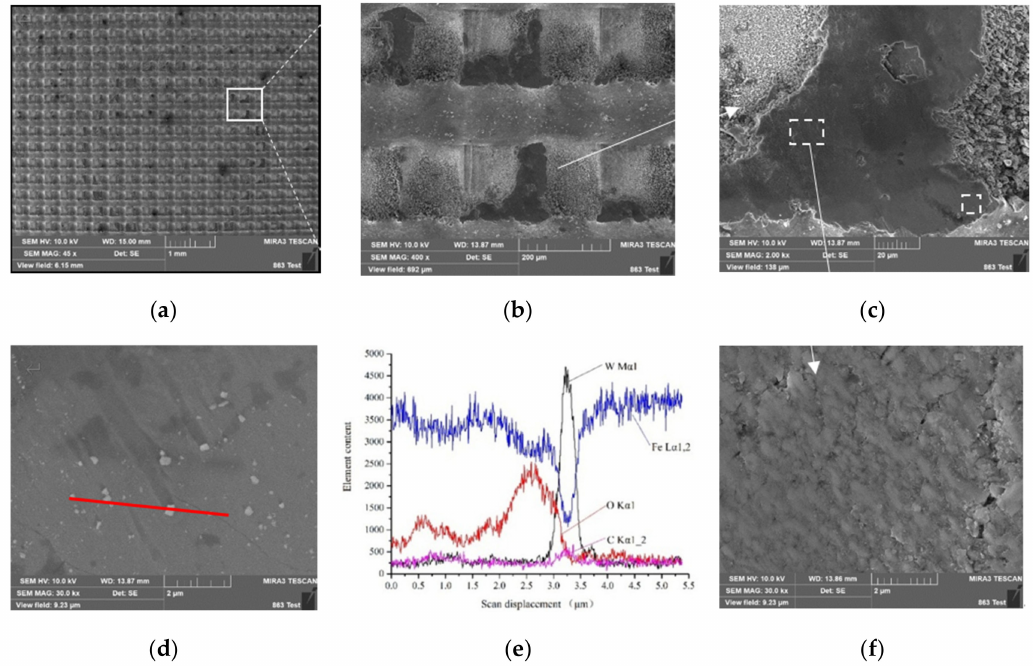
Figure 20. SEM and EDS images of the 70 W power group at 1.6 mm / s and at the load of 300 g: ( a ) wear scar morphology; ( b ) enlarged view of wear scar; ( c ) enlarged view of worn convex hull; ( d ) enlarged view of part of the worn area in Figure c; ( e ) elemental line analysis chart of Figure d; ( f ) enlarged view of part of the worn area in Figure